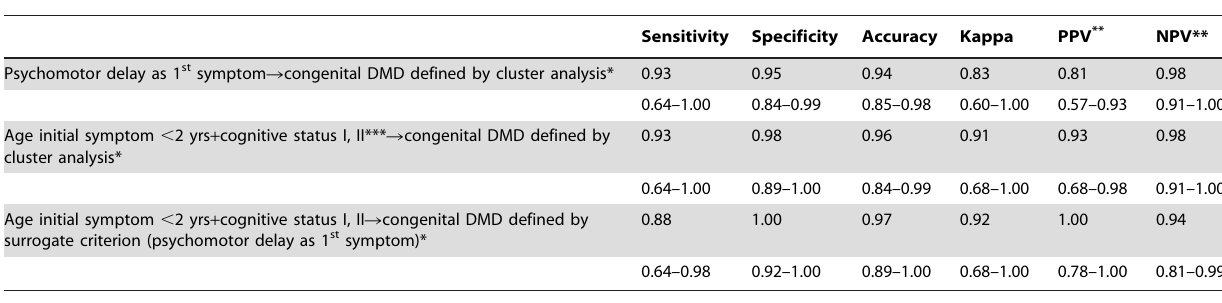
Table 3. Simplified indicators of congenital DMD (cluster A) derived from series 1.